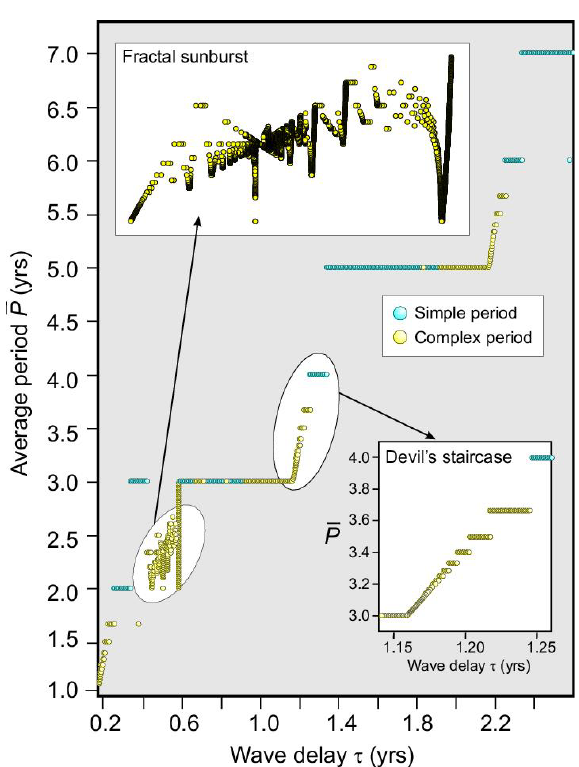
Table 3. Mean values and standard errors for the three estimators of the strength of long-range persistence for the two synthetic data sets with β = 0 . 5; see text and caption of Fig. 7 for the construction of these 2 × 100 time series. Symbols for the three analysis methods – PS, DFA and R/S – as in Table 2. The resultant distribution of persistence strengths is approximately Gaussian: the corresponding mean values Fig. 8. Spectral analysis (Lomb periodogram) results for the 622 to 1900 A.D. Nile River annual minimum and standard deviations are given in the table. (red triangles) and maximum (blue squares) water level time series (see Fig. 1). Shown are the power-spectral densities S plotted as a function of frequency f on log-log scale. Blue and red lines represent the best fitting power law functions in the frequency range (1 / 128) yr − 1 < f < (1 / 4) yr − 1 , the same frequency range (period range) as done for DFA and R/S (Figure 7). The estimated long-range correlation strengths ( β the color of the corresponding line.